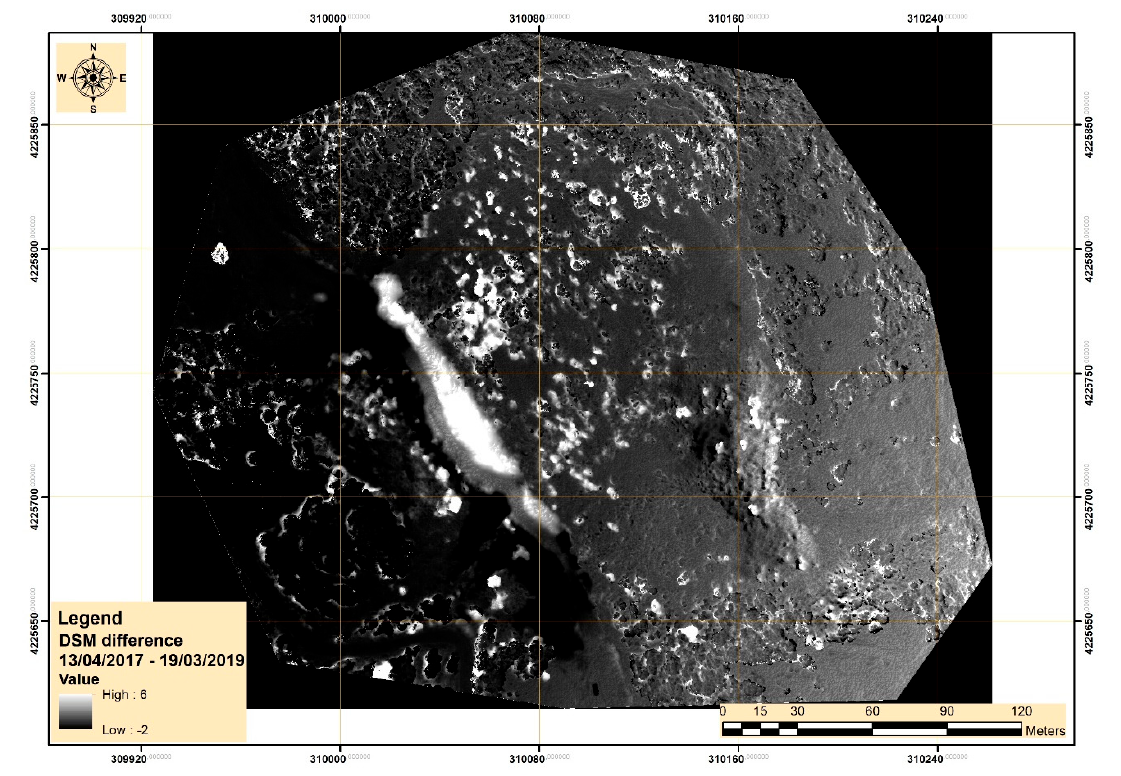
Figure 19. DSM difference between the DSMs of 13 April 2017 and 19 March 2019.